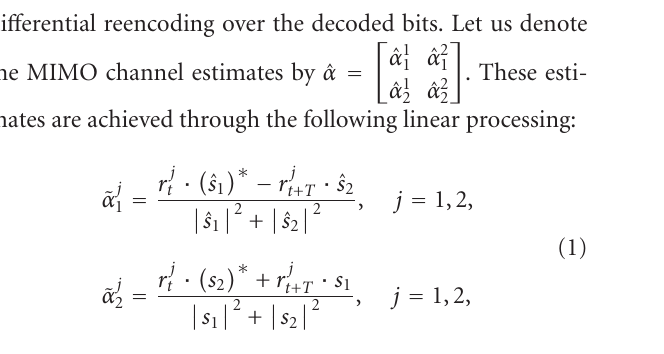
Figure 6: Receiver software flowchart.